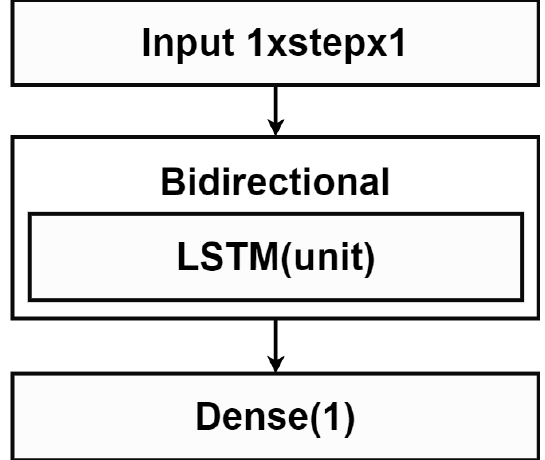
Figure 4. LSTM model in Bidirectional